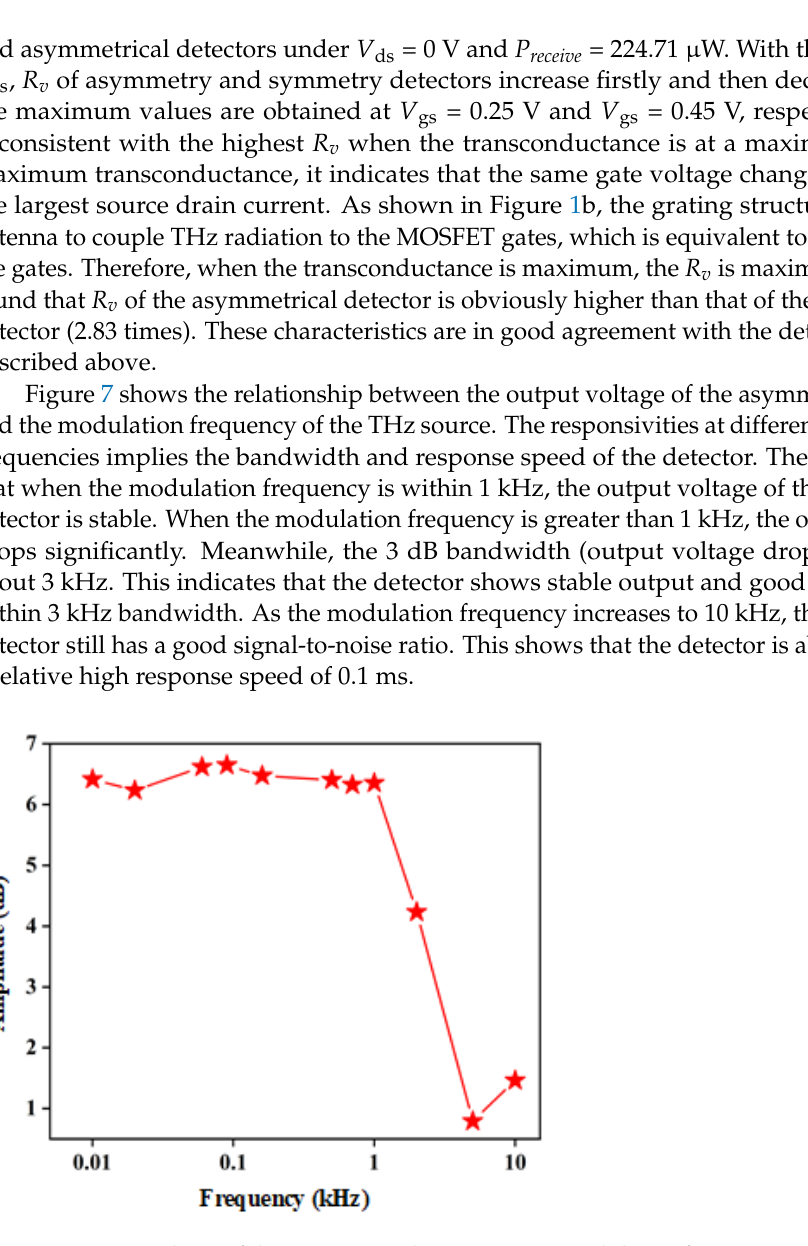
Figure 7. Output voltage of the asymmetry detector versus modulation